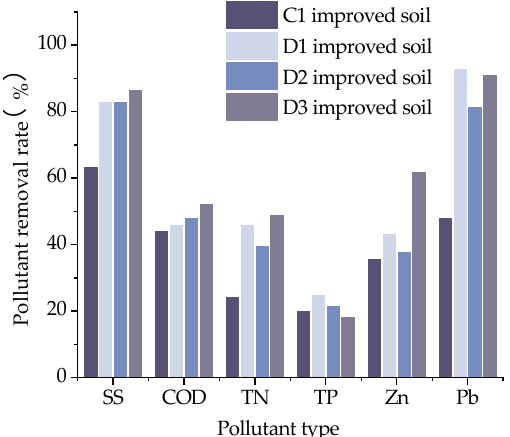
Figure 14. Pollution removal rate of soil amended with structural ameliorants.